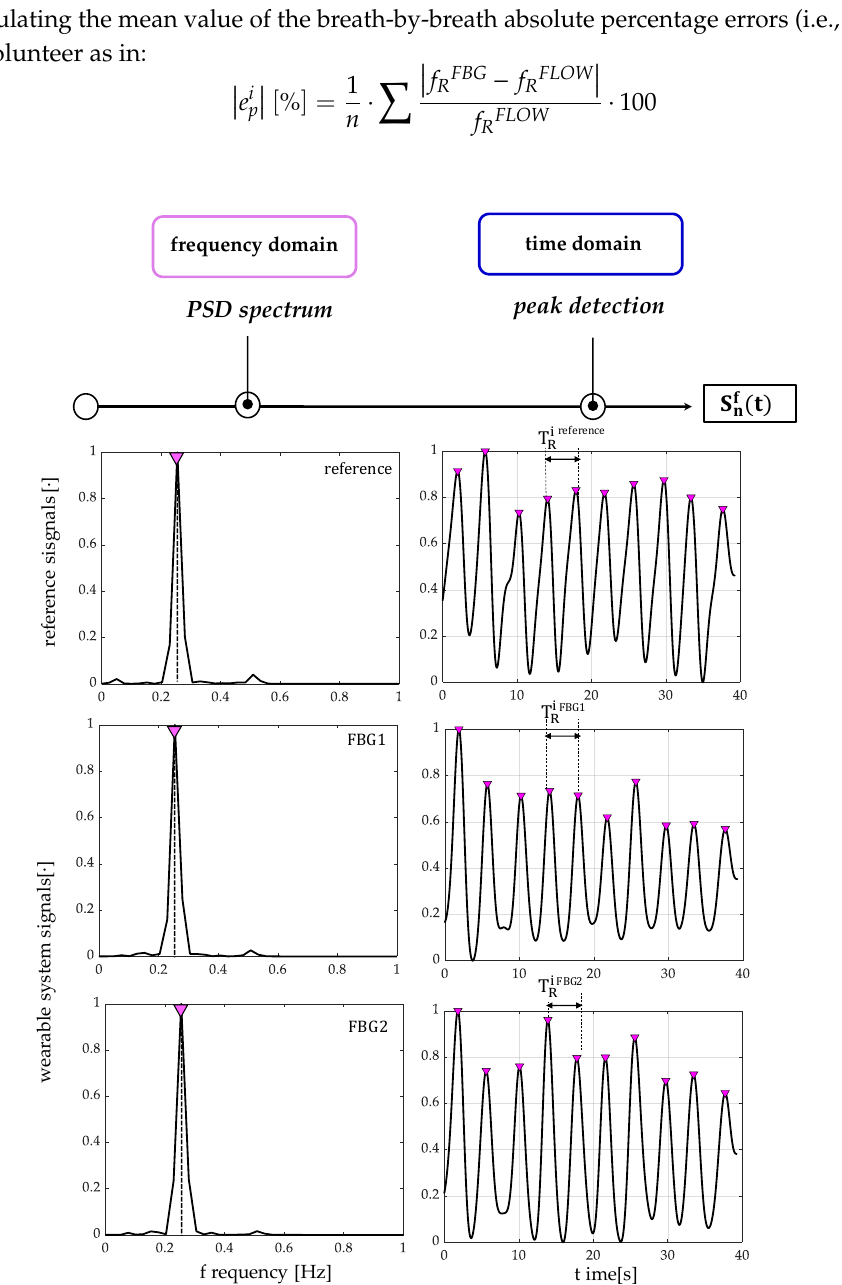
Figure 7. An example of signals processing performed for the f R estimation from data recorded by the flowmeter and the wearable systems, during quiet breathing. The power spectral density (PSD) spectra over frequency [Hz] and the peak detection over time [s] are shown for both the reference system and the proposed wearable system based on two flexible sensors (FBG1 and FBG2). The S f n (t) signals are filtered and normalized.